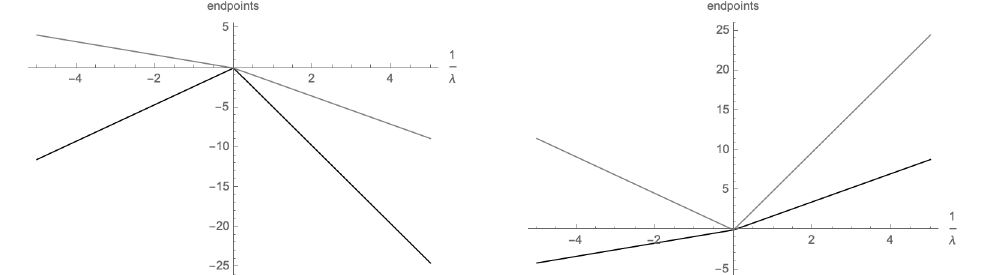
Figure 5 . Plot of A (black) and B (gray) in the pure gauge theory. Left: t = 1 . 3 . Right: t = − 1 . 3